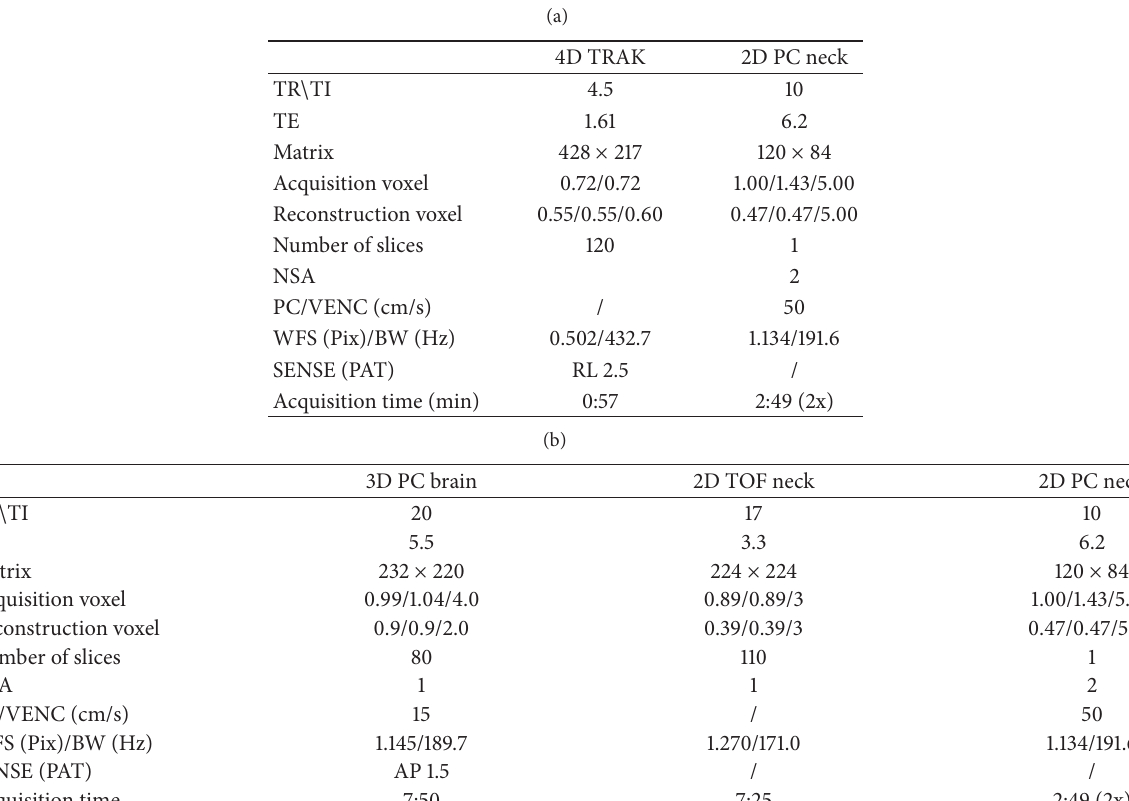
Table 1: Technical parameters for MRV two-tier protocol, with (a) and without (b) contrast